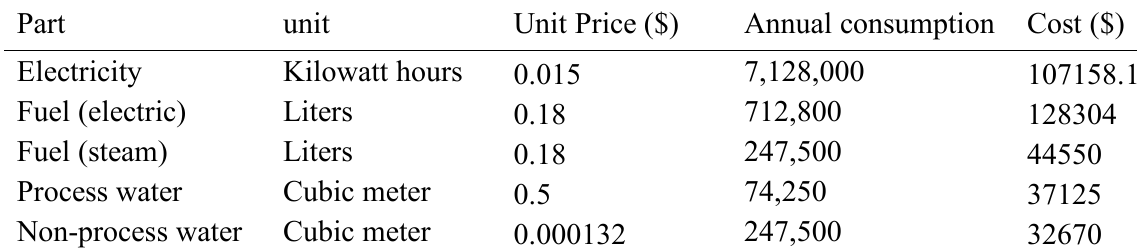
Table 11. Production side requirements